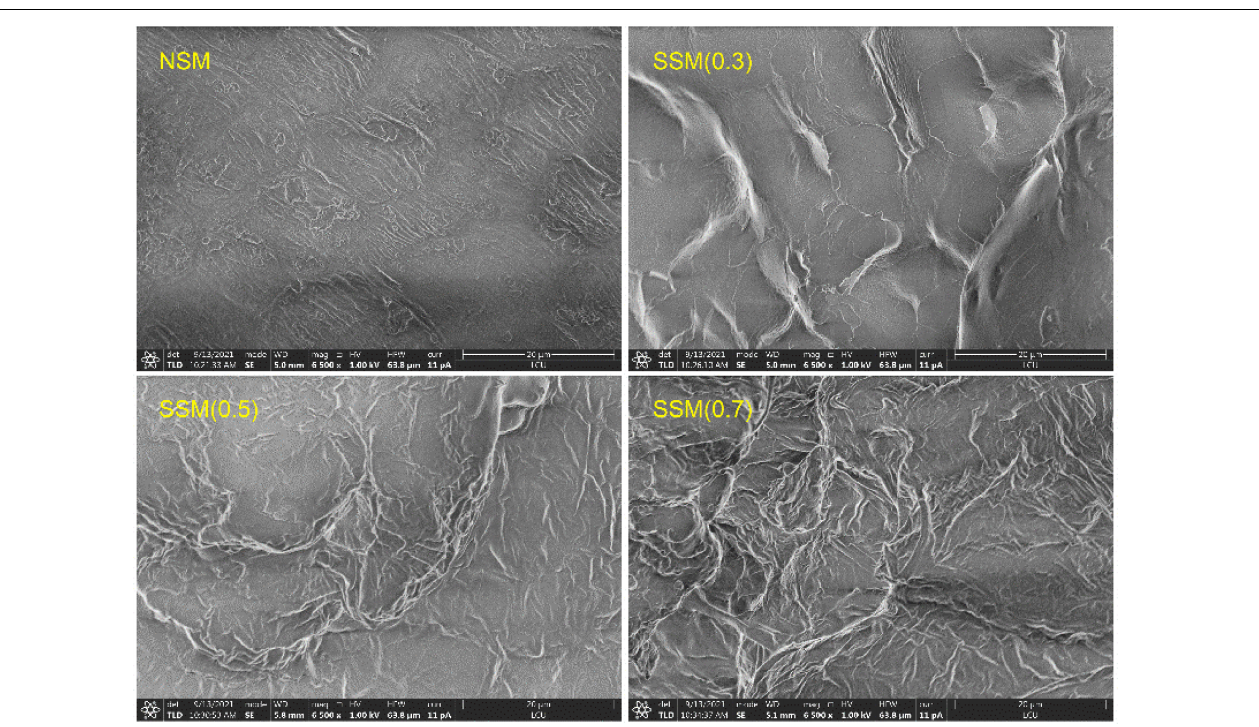
FIGURE 1 | The scanning electronic micrograph (SEM) images of soybean meal. NSM, native soybean meal; SSM, steam-exploded soybean meal, SSM (0.3), SSM (0.5), and SSM (0.7) indicated steam explosion pressure were 0.3, 0.5, and 0.7 MPa,